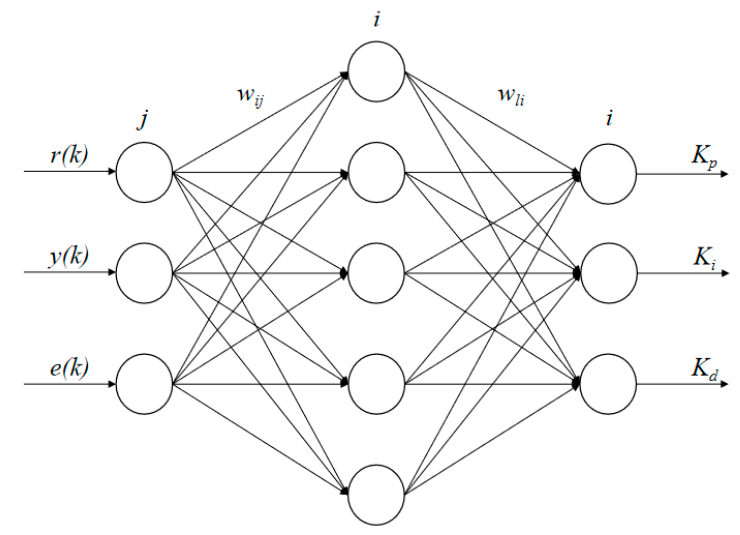
Figure 8. Structure of PID control system based on BP neural network.